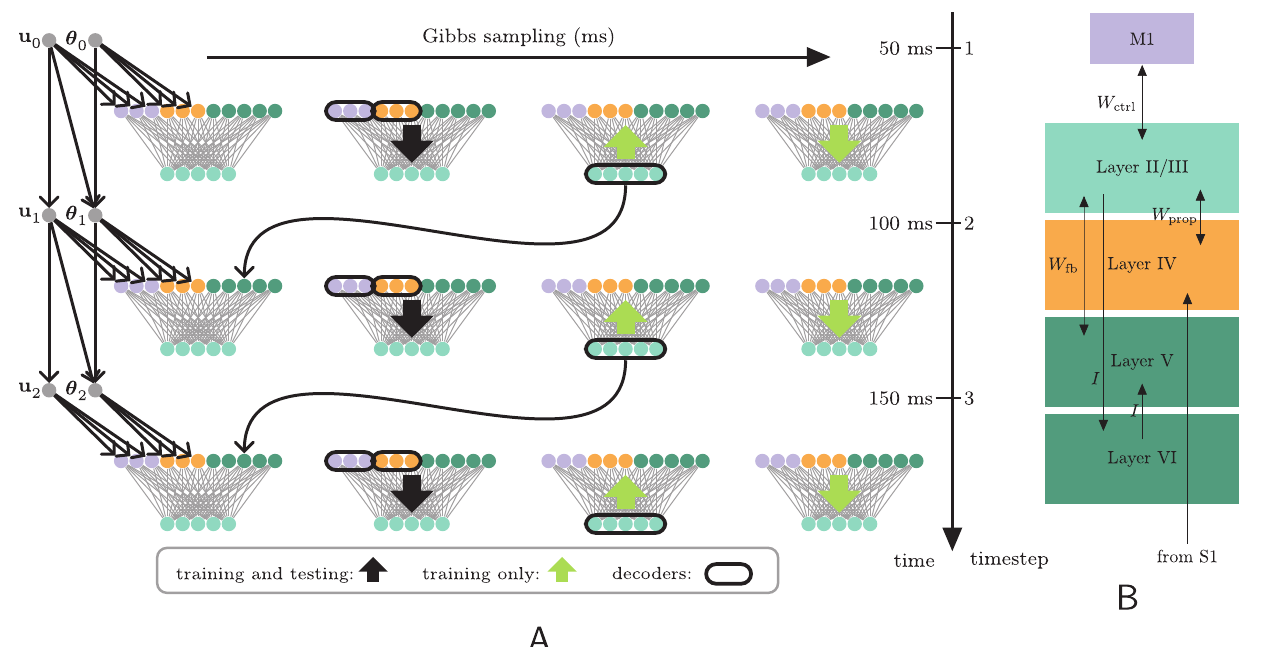
Fig 9. Training and testing: in the model, and in a cortical implementation. (A) The training and testing procedure in the model. Three discrete times steps are arrayed vertically. At each one, the current arm position ( θ t ) is reported by the proprioceptive population (orange) with Poisson-distributed spike counts, as shown in the first column. The current motor command is likewise reported by an “ efference-copy ” population (purple). Second column: this spiking, along with recurrent activities (dark turqoise), stochastically drives single spikes in the hidden layer (turquoise). Third column: these spikes in turn drive the three “ input ” populations (this is not required during testing); a “ copy ” of the hidden vector is also saved to serve as recurrent activity at the next time step (curved black arrow). Fourth column: finally, the input populations drive the hidden layer once more, after which the weights are changed according to Eq. 9 (also not required during testing). At every time step, the current joint angle and current control are decoded na ï vely from the current activities of their respective input populations; with Kalman filters that are recursively updated based on these activities (not depicted in this figure); and from the hidden units of the rEFH. (B) A possible cortical implementation of the rEFH. The cortical layers of Brodmann Area 5 and its inputs are identified with elements of the rEFH by color. The synaptic connections are denoted by the arrows and their corresponding weight matrices. Primary somatosensory cortex (S1) provides feedforward proprioceptive input to layer IV, while primary motor cortex (M1) provides feedback input — a copy of the efferent command — to layer II/III. The recurrent signal of the rEFH (heavy curved arrow in (A)) is identified with a reverberatory loop from II/III to VI, to V, and back to